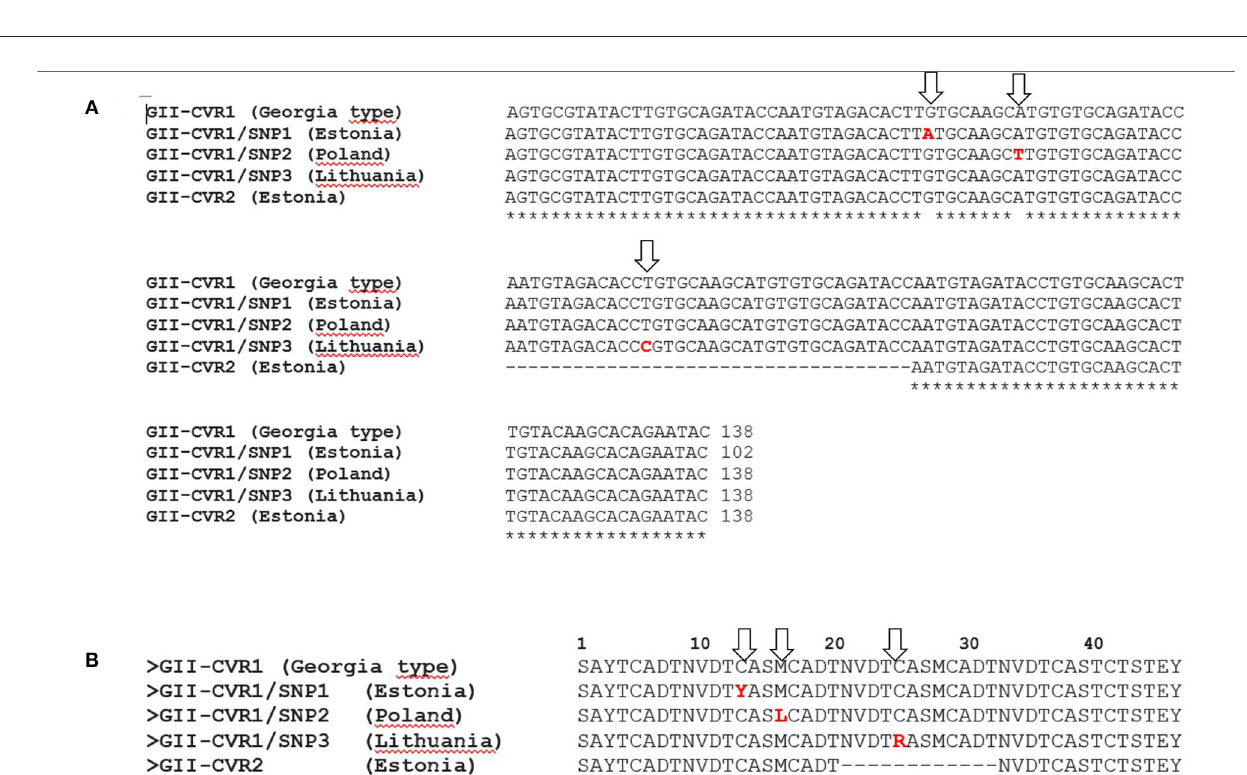
FIGURE1 Nucleotide (A) and amino acid (B) sequence alignment of the variants identified in the central variable region (CVR) of the B602L gene in the EU genotype II-ASFVs. In red are showed the variations marked with arrows.